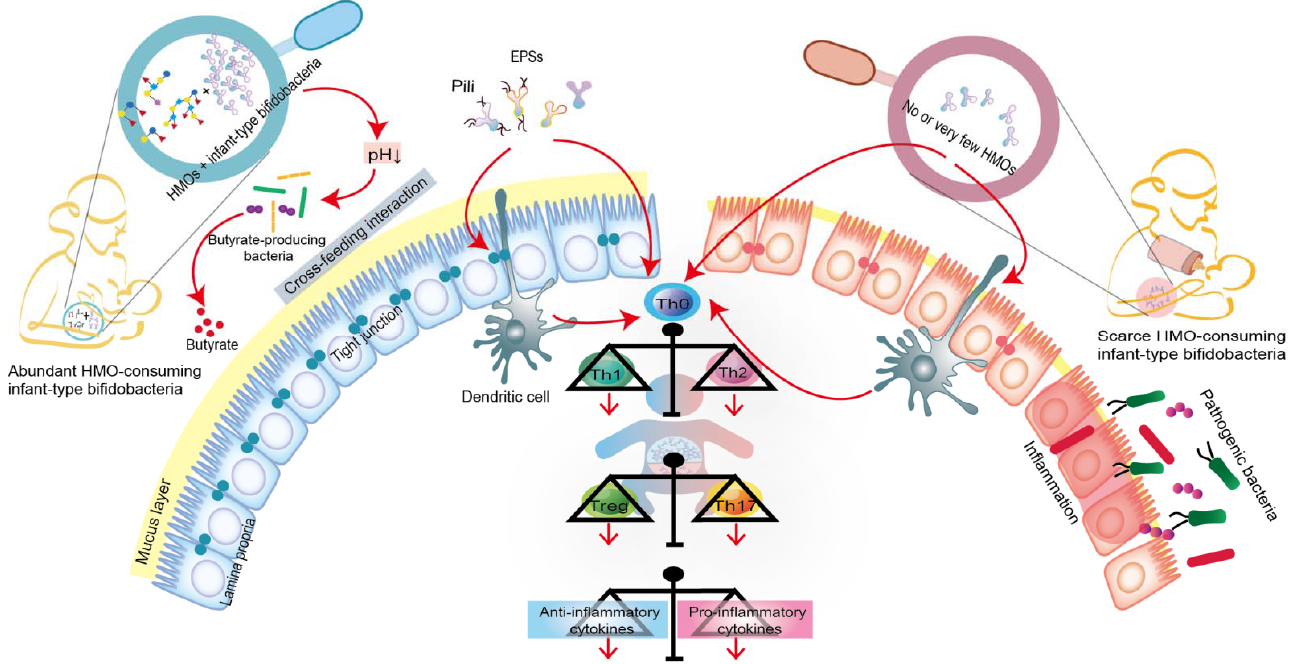
Figure 2. Co-evolution of intestinal infant-type bifidobacteria and HMOs-mediated immune system imprinting early in life. Breastfed infants are rich in intestinal infant-type bifidobacteria, which is significantly correlated with the increase in anti-inflammatory cytokines. In contrast, infants without breastfeeding have lower or no intestinal infant-type bifidobacteria, resulting in increased levels of pro-inflammatory cytokines. Although the exact mechanism is still elusive, infant-type bifidobacteria are widely considered to successfully modify the intestinal microecology in the early stages of life and prevent the progress of immune-mediated diseases, at least, by producing short- chain fatty acids (SAFAs), encoding extracellular structures (exopolysaccharides (EPSs) or/and pili), promoting cross-feeding effects, skewing T cell polarization, and promoting the expression of anti-inflammatory